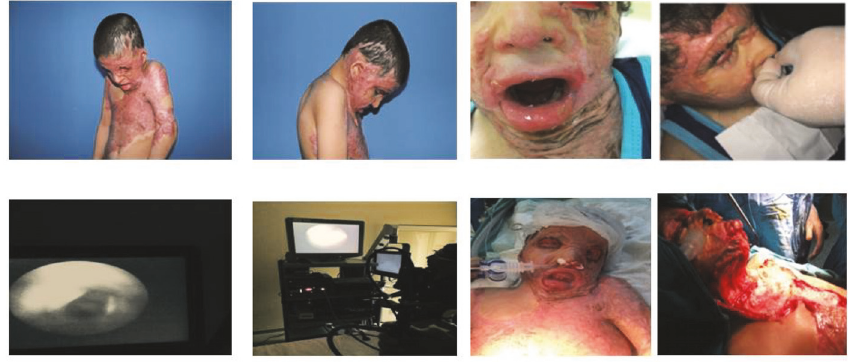
Figure 1: Patient’s perioperative